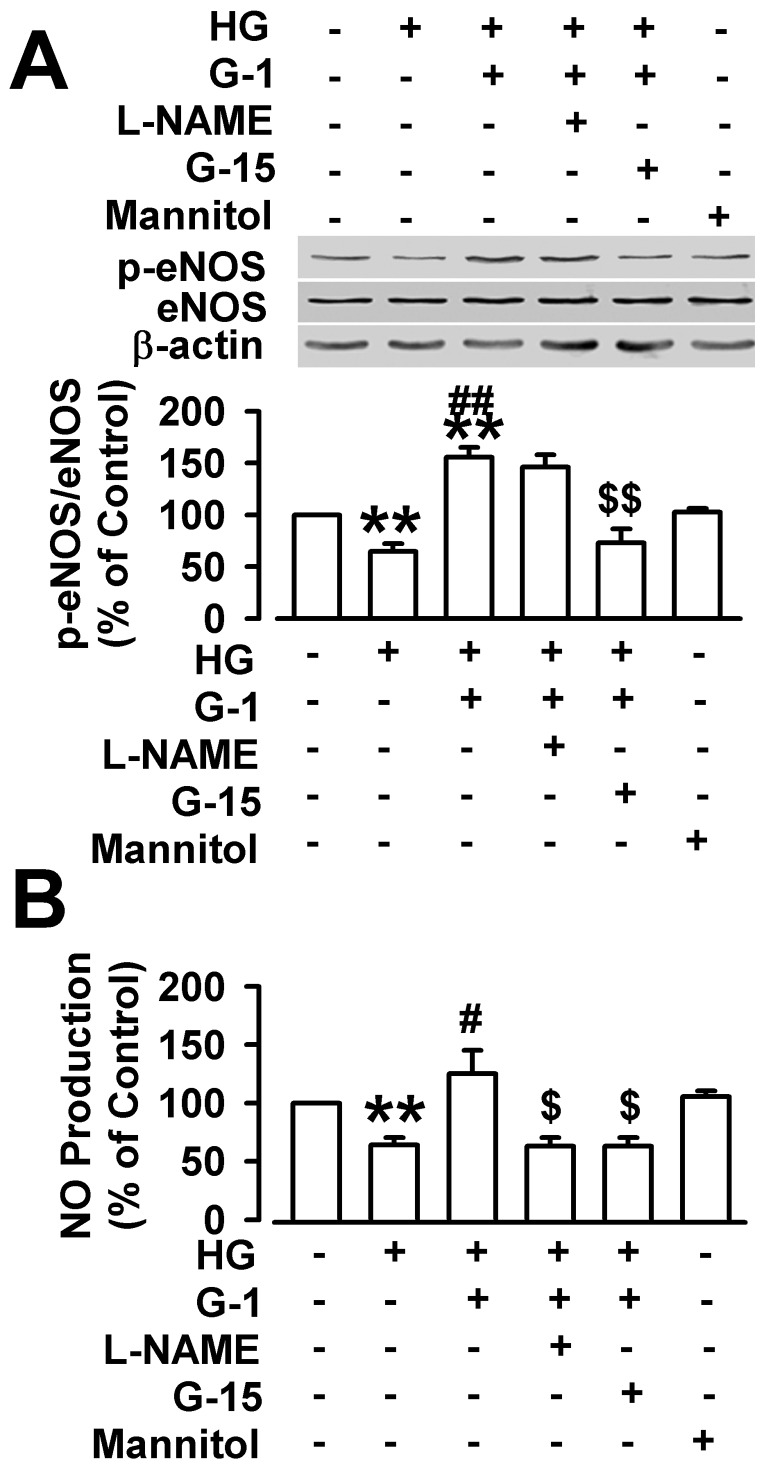
Activation of eNOS signaling pathway mediated protective effects of G1.The endothelial cells were treated with high glucose (HG) for 72 h, and then treated with L-NAME (100 µM) for 40 min and G15 (1 µM) or without them in presence of G1 (10 nM) for 10 min. (A) G1 treatment (10 nM, 10 min) reversed the down-regulation of phosphorylation level of eNOS by high concentration of glucose. This effect was blocked by G15. (B) G1 reversed the NO reduction in endothelial cells exposure to HG. This effect of G1 was blocked by L-NAME and G15. High concentration of mannitol (33 mM) did not alter the phosphorylation level of eNOS. **
p<0.01 compared with the glucose treated before; #
p<0.05, ##
p<0.01 compared with the HG treated; $
p<0.05, $$
p<0.01 compared with the HG+G1 treated. Results are given as the mean ± SEM of three independent experiments.